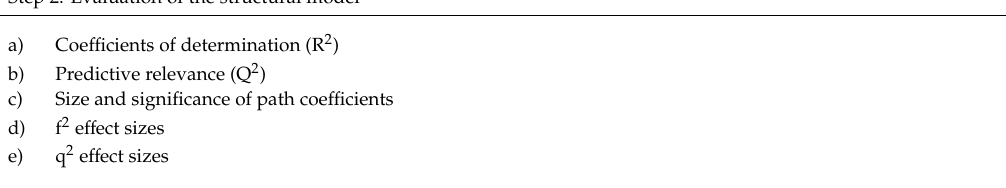
Table 1. Stepwise process to evaluate model results.